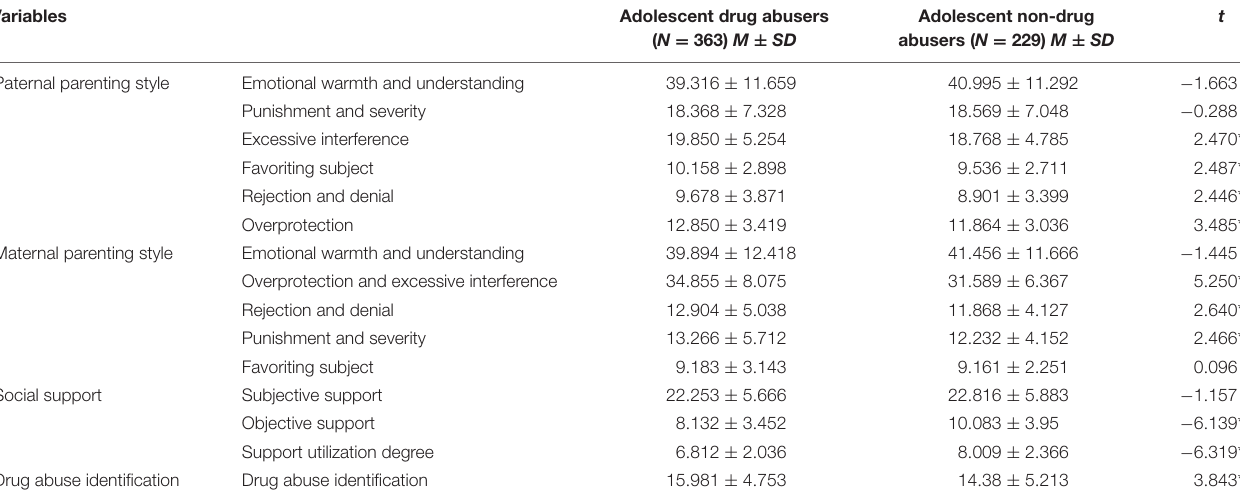
TABLE 1 | Difference tests of all study variables for adolescent drug abusers and non-drug abusers. Variables